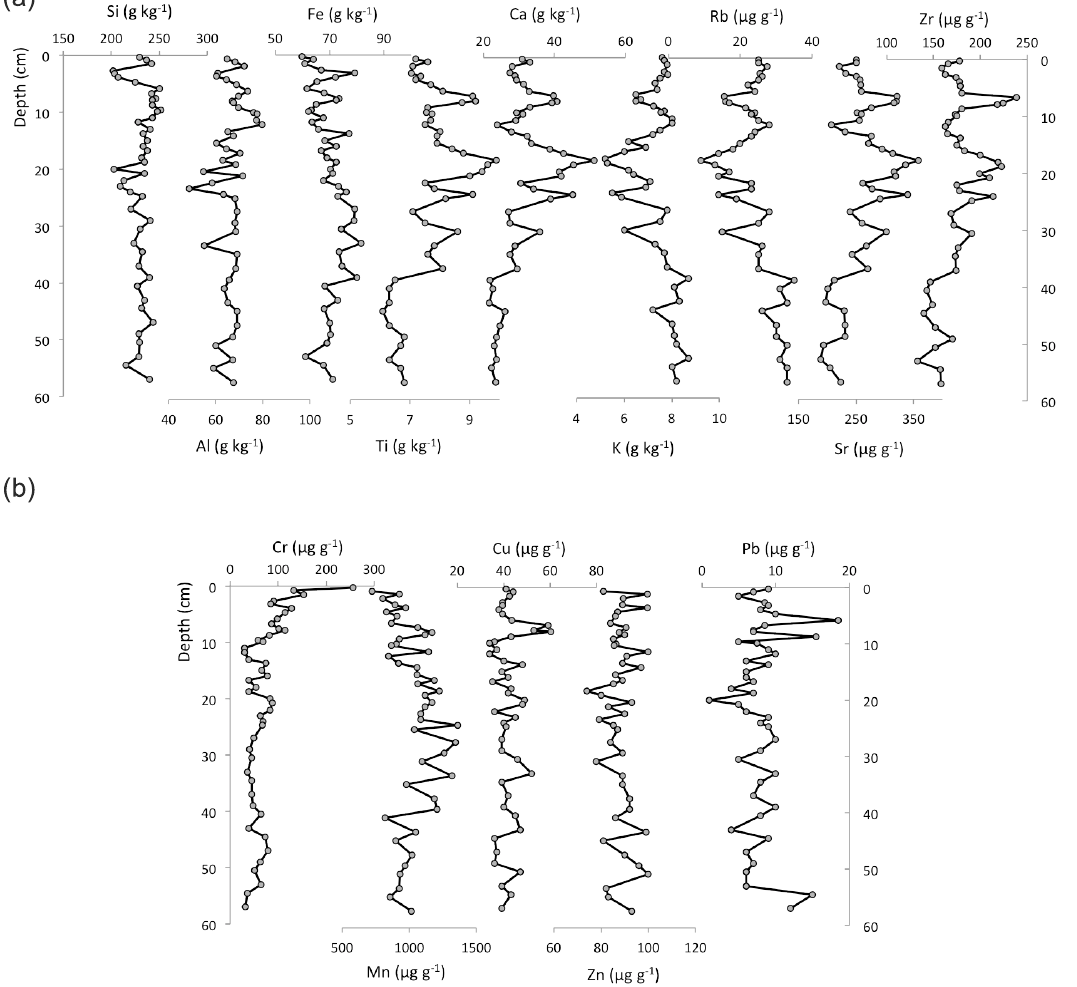
Figure 2. Depth records of concentrations of the elements analyzed in the LIM03/1 core of Limnopolar Lake. (a) Major, minor, and trace lithogenic elements; (b) metallic